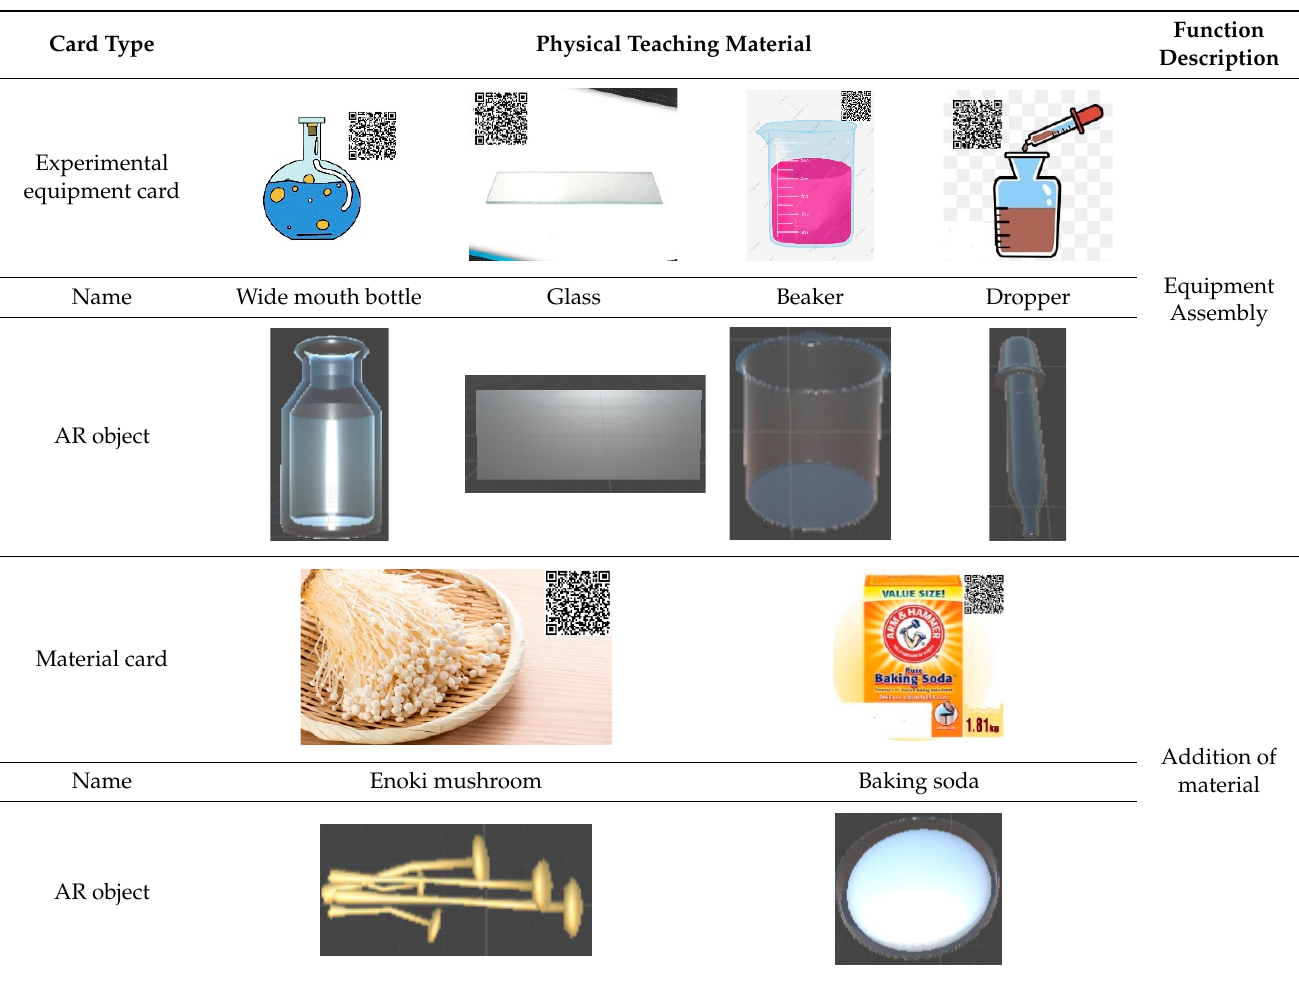
Table 5. Card designs and function descriptions.